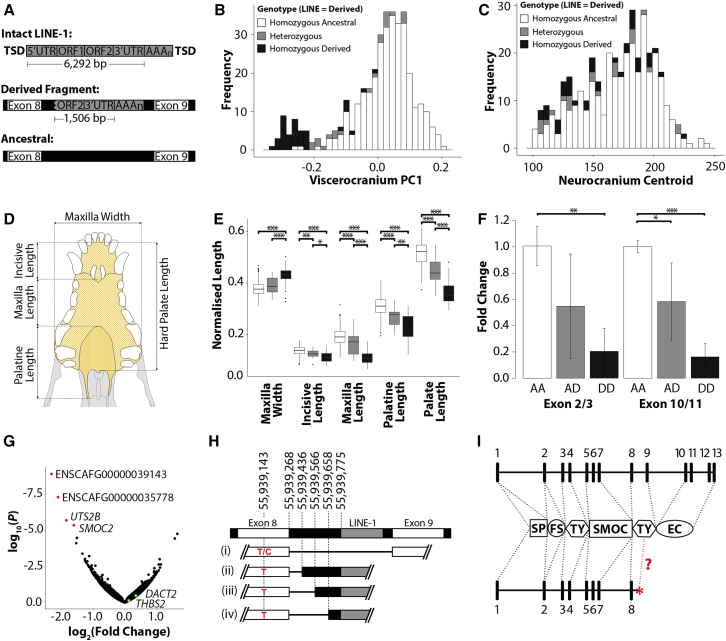
Characterization of the Intronic LINE-1 Retrotransposon within SMOC2(A) Schematic of a full-length canine LINE-1 element consisting of 5′ UTR/3′ UTR, open reading frames 1 and 2 (ORF1/ORF2), and a polyadenylated tail (AAAAn) flanked by target site duplications (TSD). The structural variant within SMOC2 is 1,506 bp in length (in addition to a poly(A) tail) and has a 99.1% match to the consensus sequence of canine LINE-1.(B and C) Distribution of the SMOC2 LINE-1 fragment for (B) viscerocranium PC1 and neurocranium centroid size (C) across all individuals.(D) Ventral-dorsal view of the canine hard palate and its constituent bones.(E) Length and width of the canine palate and constituent bones normalized by the neurocranium centroid for homozygous ancestral (white), heterozygotes (gray), and homozygous-derived (black) individuals for the SMOC2 LINE-1 insertion.(F) Relative expression levels of SMOC2 both up- and downstream of the LINE insertion (<0.05 ∗; <0.01 ∗∗; <0.001 ∗∗∗). Error bars represent SEM.(G) RNA sequencing (RNA-seq) data reveal four genes with significant changes in mRNA levels (red) for homozygous SMOC2 LINE-1 carriers compared to non-carriers (three each). Neighboring genes to SMOC2 are colored green.(H) Schematic of genomic DNA (gDNA) spanning exon 8 and 9 of SMOC2, including the LINE-1 fragment. mRNA transcripts include the canonical splicing of SMOC2 (i) followed by the three most abundant SMOC2 isoforms when the LINE-1 element is present (ii–iv). All isoforms have premature stop codons prior to exon 9. C/T indicates the SNP in exon 8. Schematic is not to scale.(I) Exons 1–13 of SMOC2 contribute to a follistatin-like module (FS), thyroglobulin-like modules (TY), a unique SMOC module, an extracellular calcium-binding module (EC), and a signal peptide (SP).See also Figures S5 and S7 and Tables S5 and S6.